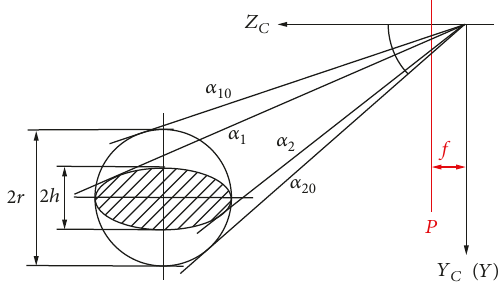
Figure 4: Vertical camera ellipse and disc projection models.